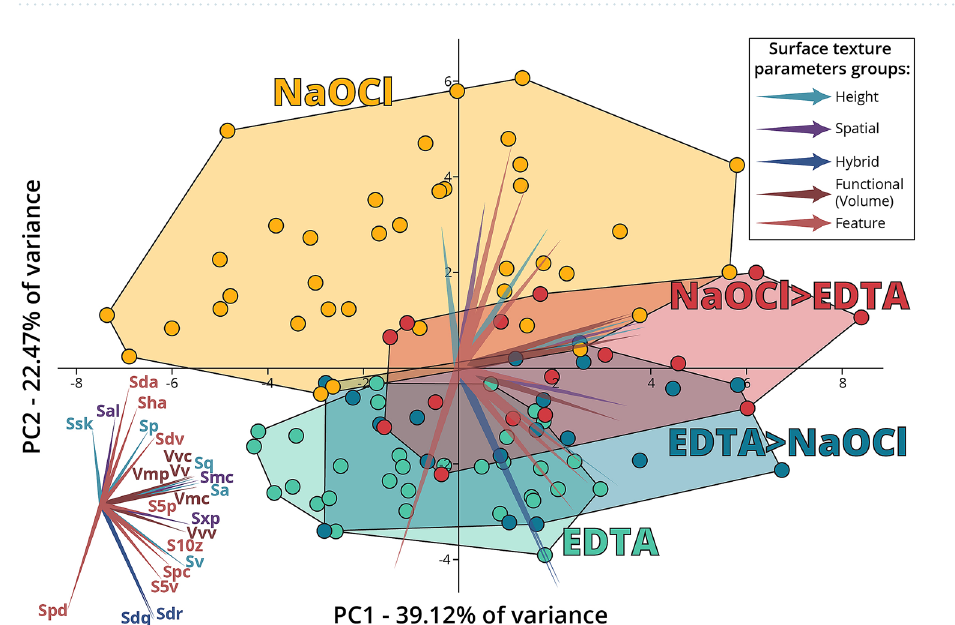
Figure 3. Between-group PCA of the dentin surface roughness parameters. Graphic presentation of the overall difference between the four experimental groups (E, EN, N and NE). The first two principal components explain 61.59% of the variance of the measured surface texture parameters (ISO 25178-2 24 ). The list of abbreviations is listed in Table 1. Each parameter is designated as a vector that indicates the contribution of the parameter to the difference between the regions. The parameters are divided into five groups (each highlighted by a different color) according to the surface pattern (see Table